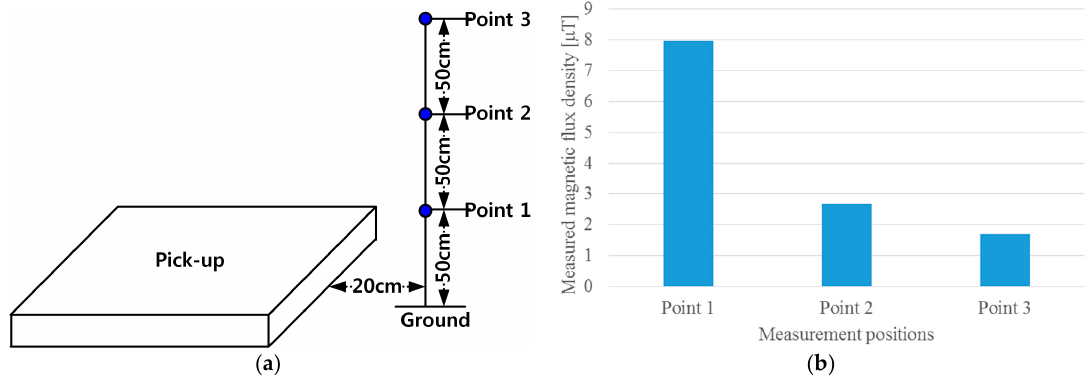
Figure 14. Magnetic field radiation measurement positions and measured results: ( a ) measurement positions; ( b ) measured magnetic flux density.